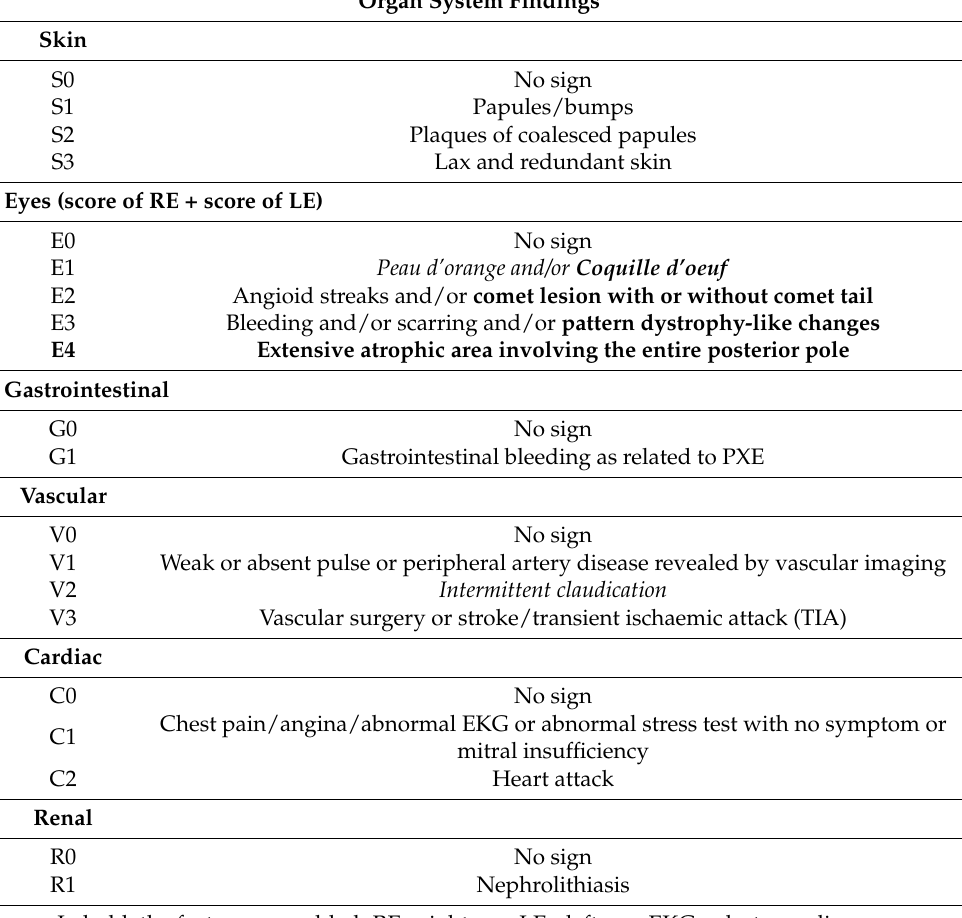
Table 3. Phenodex-FlorMore scoring system for the evaluation of PXE clinical manifestations. Organ System